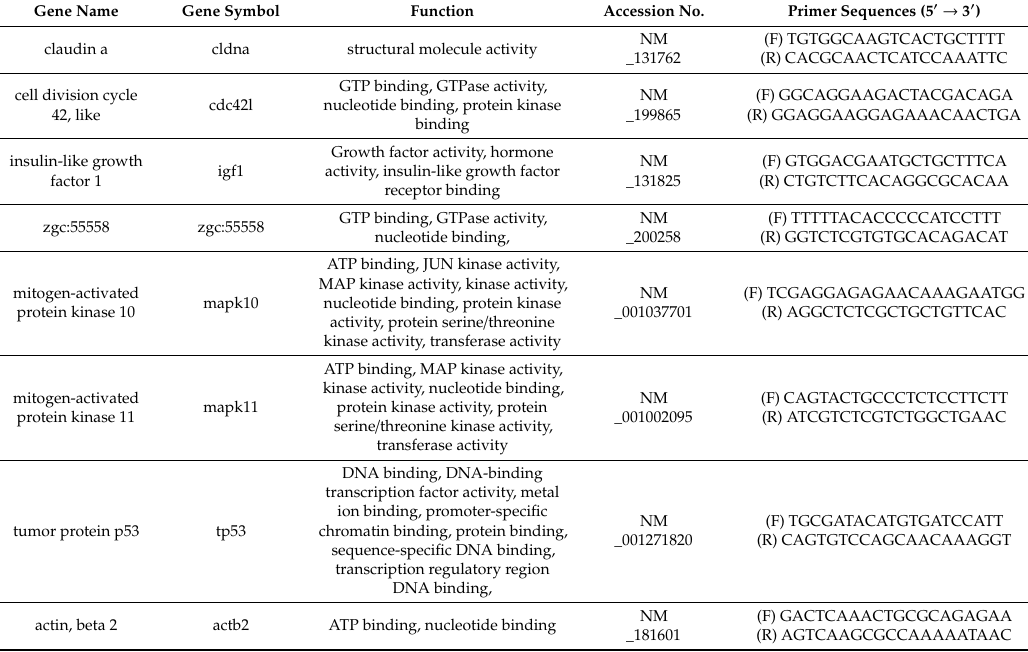
Table 1. Primer of key genes involved in the signaling pathway selected for